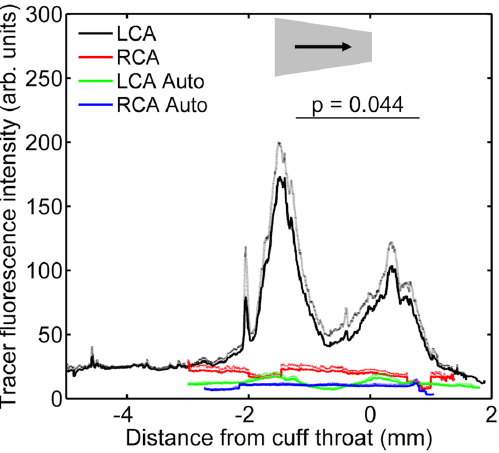
Fig. 10. Tracer uptake along vessels with the cuff in the conventional orientation. Fluorescence intensity along the length of carotid arteries of mice having the cuff placed around their left carotid in the conventional direction. Intensity is shown separately for the cuffed left carotid (‘‘LCA’’) and uncuffed right carotid (‘‘RCA’’) of mice administered tracer or not administered tracer (indicating autofluorescence; ‘‘Auto’’). Flow direction, cuff location and cuff orientation are indicated as described for Fig. 2. Mean (dark lines) + 1 SEM (light lines), n 5 10 for mice given tracer and n 5 3 for